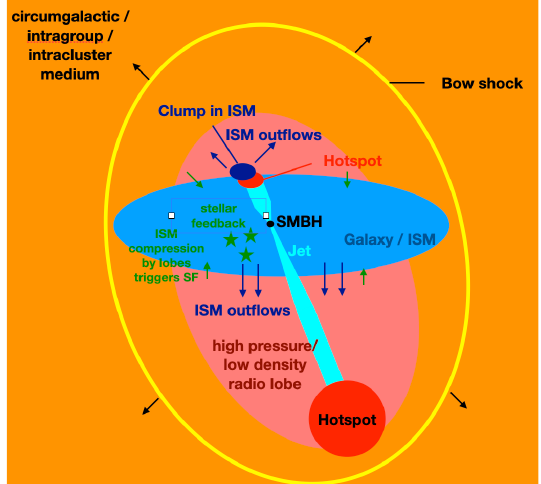
Figure 1. Schematic of features expected in connection with radio-mode feedback in star-forming galaxies. Jets are produced from supermassive black holes (SMBH). The ISM in star-forming